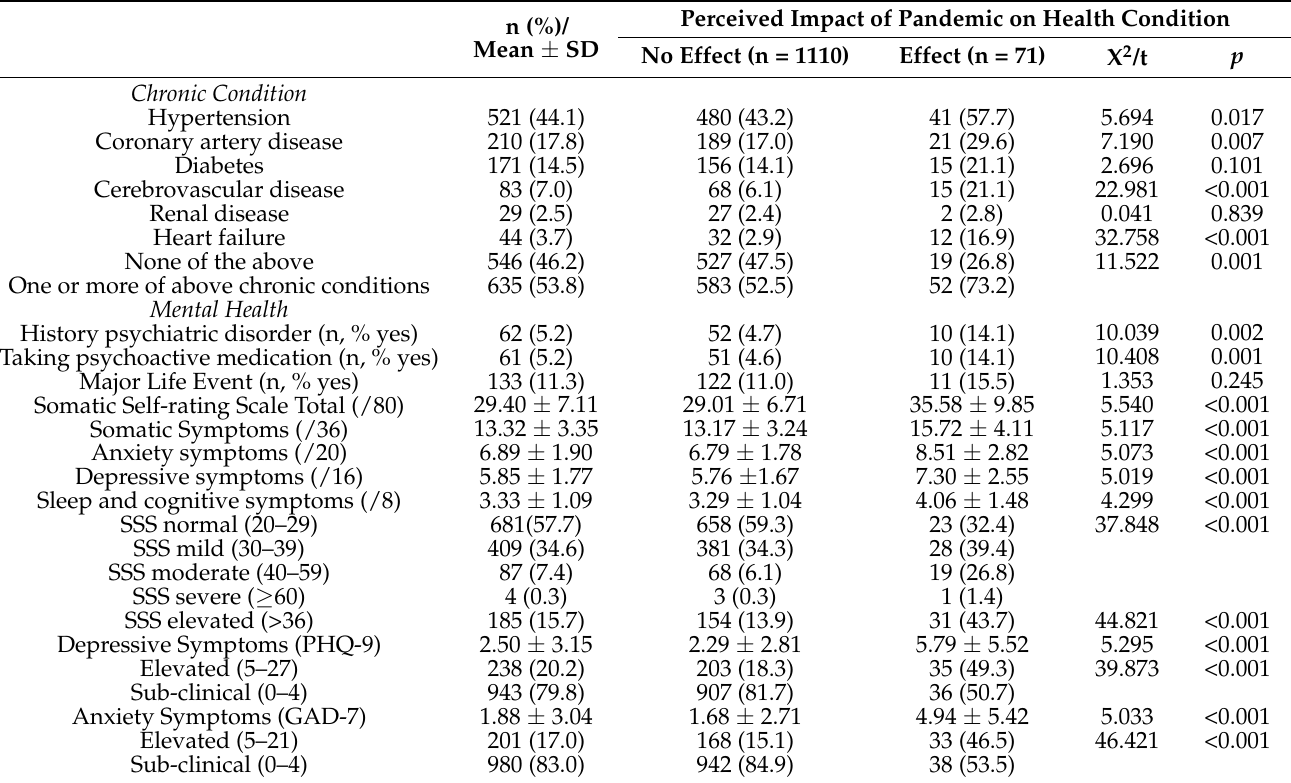
Table 2. Participant Physical and Mental Health and Association with Perceived Pandemic Impact on Health, N =